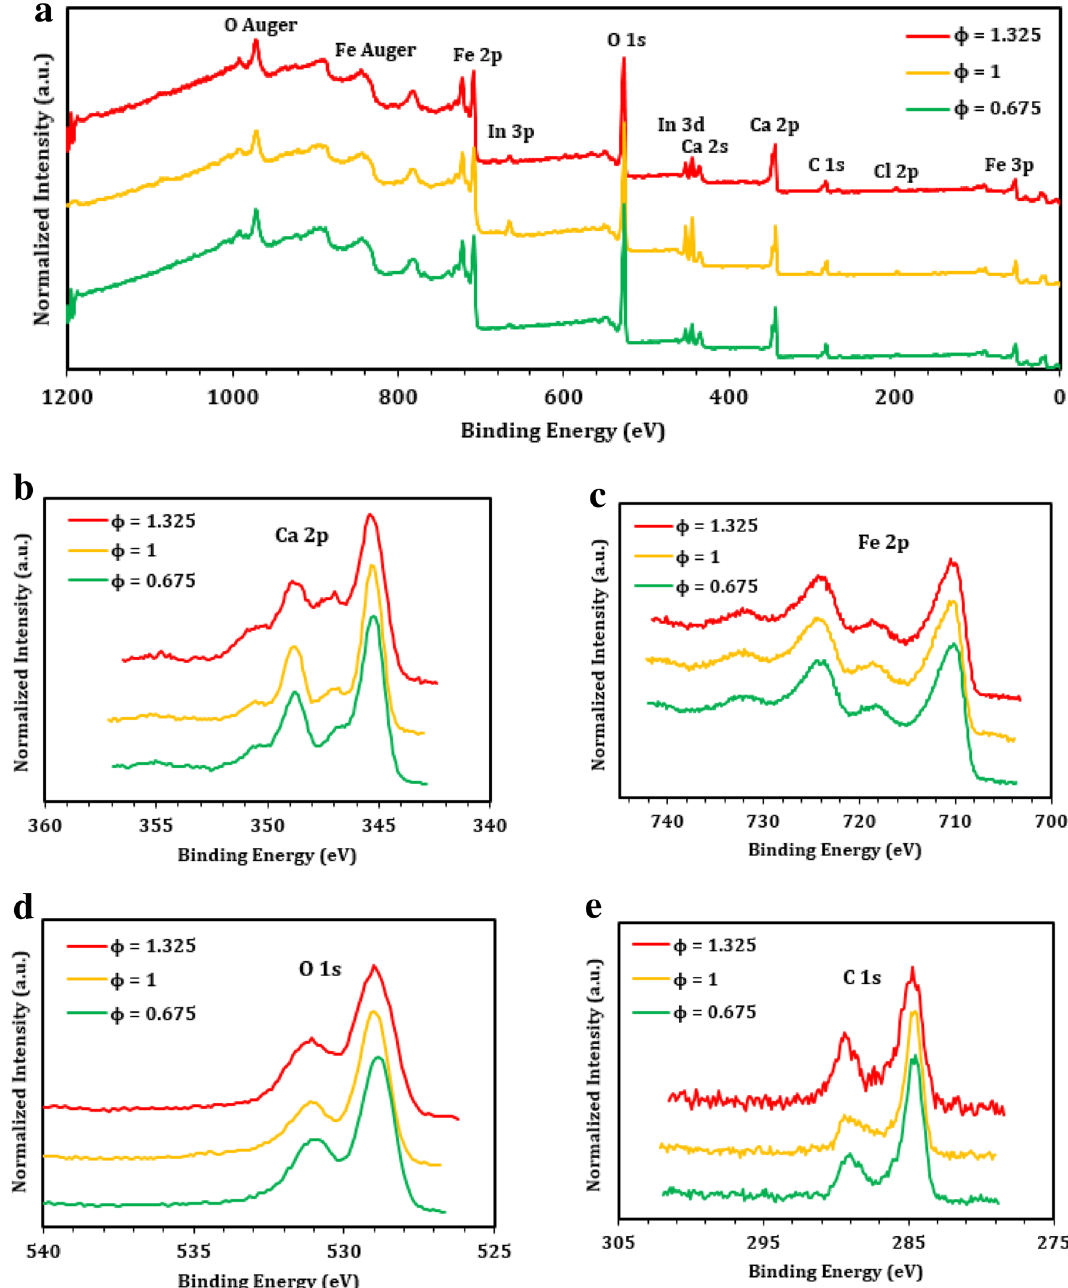
Figure 4. XPS spectra of pCFO synthesized at increasing ϕ and calcined at 900 °C: ( a ) survey scan, ( b ) Ca 2p scan, ( c ) Fe 2p scan, ( d ) O 1 s scan, and ( e ) C 1 s scan. Spectra have been normalized to global maxima and vertically offset for